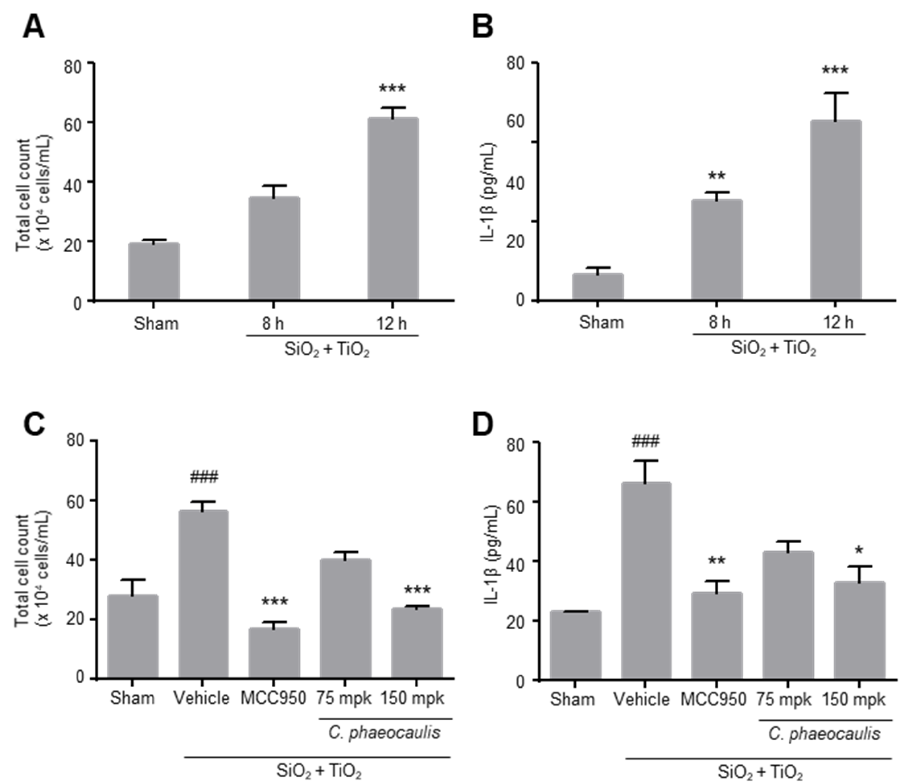
Figure 5. The effects of C. phaeocaulis extract on the nanoparticle-induced airway inflammation in mice. SiO 2 (20 mg/kg) and TiO 2 (20 mg/kg) were administered by intratracheal instillation following anesthesia with pentobarbital. At 8 or 12 h after the nanoparticle instillation, BALFs were analyzed for total cell counts ( A ) and IL-1 β ( B ). Data are expressed as mean ± standard error (SE), and different symbols indicate differences at ** p < 0.01, *** p < 0.001 vs. sham group. ( C , D ) C. phaeocaulis extract was orally administered 1 h before and 4 h after intratracheal instillation of nanoparticles. At 12 h after the nanoparticle instillation, BALFs were analyzed for total cell counts and IL-1 β , respectively. MCC950 was used as a reference compound inhibiting NLRP3 inflammasome. Data are expressed as mean ± SE, and different symbols indicate differences at ### p < 0.001 vs. sham group; * p < 0.05, ** p < 0.01, *** p < 0.001 vs. SiO 2 + TiO 2 + vehicle administered